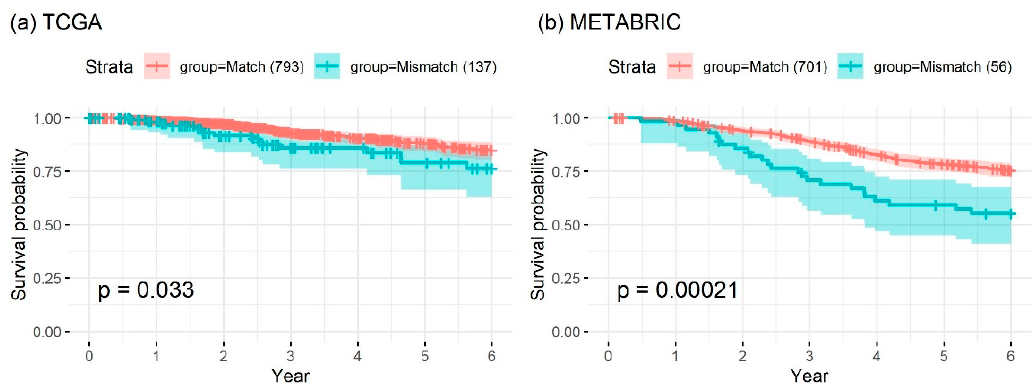
Figure 5. Kaplan–Meier survival analysis of patients in the ( a ) TCGA BRCA cohort and ( b ) METABRIC